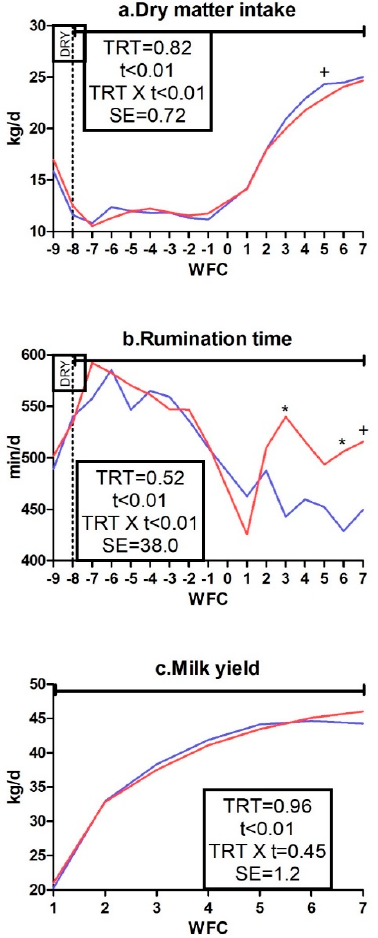
Figure 2. Average week values of dry matter intake ( a ), rumination time ( b ), and milk yield ( c ) in control dairy cows (CTR; blue line, n = 5) and cows receiving 65 g*d − 1 of Omnigen-AF ® as top-dress (IMS; red line, n = 5) between − 55 and 42 days from calving. Upper solid line indicates timing of treatment administration. TRT is treatment effect; t is time effect; TRT × t is the treatment × time interaction effect ( + is p < 0.10). WFC is weeks from calving; DRY is dry-off day ( − 55 days from expected calving). SE is standard error.